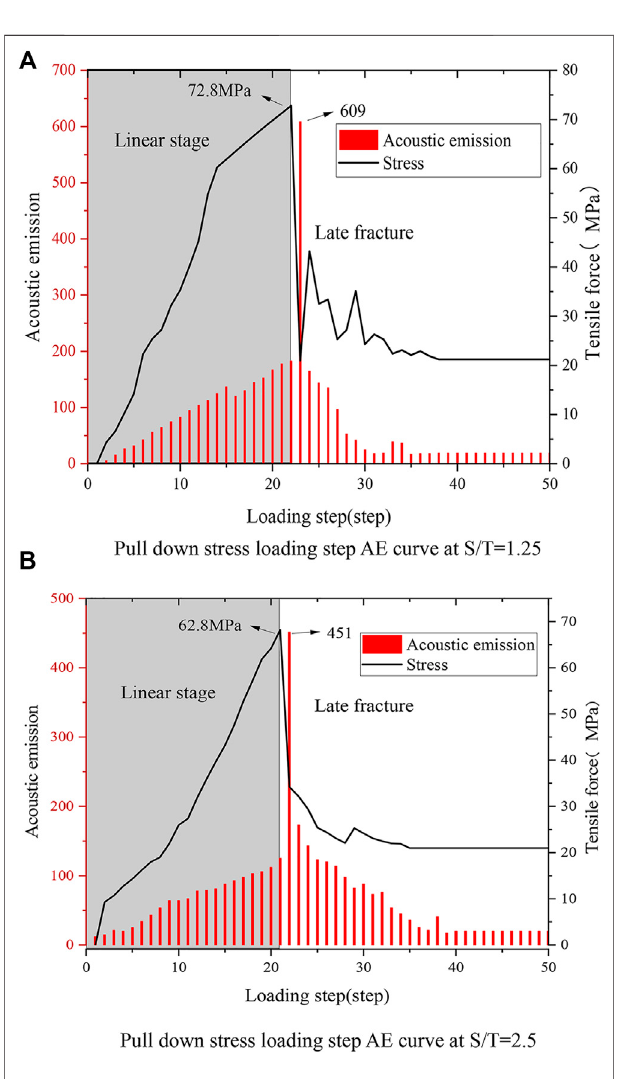
FIGURE 10 | Different S/T Stress-Load Step-Sound Emission. (A) Pull down stressloadingstep AE curve at S/T =1.25, (B) Pull down stress loading stepAEcurveatS/T=2.5, (C) PulldownstressloadingstepAEcurveatS/T= 3.75, and (D) Pull down stress loading step AE curve at S/T = 5.